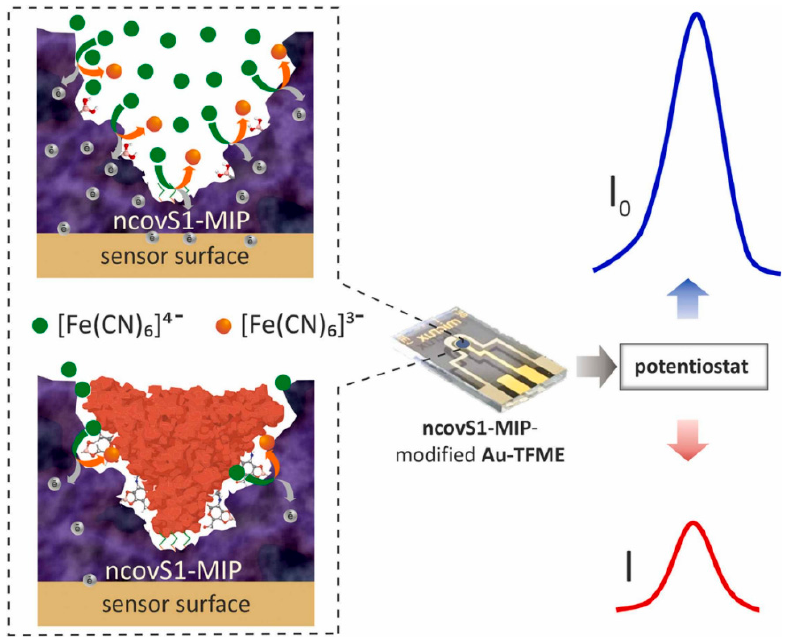
Figure 5. Representation of the measurement in a redox marker solution upon the rebinding of the target analyte. Reprinted with permission from [65]. 2022, Elsevier.